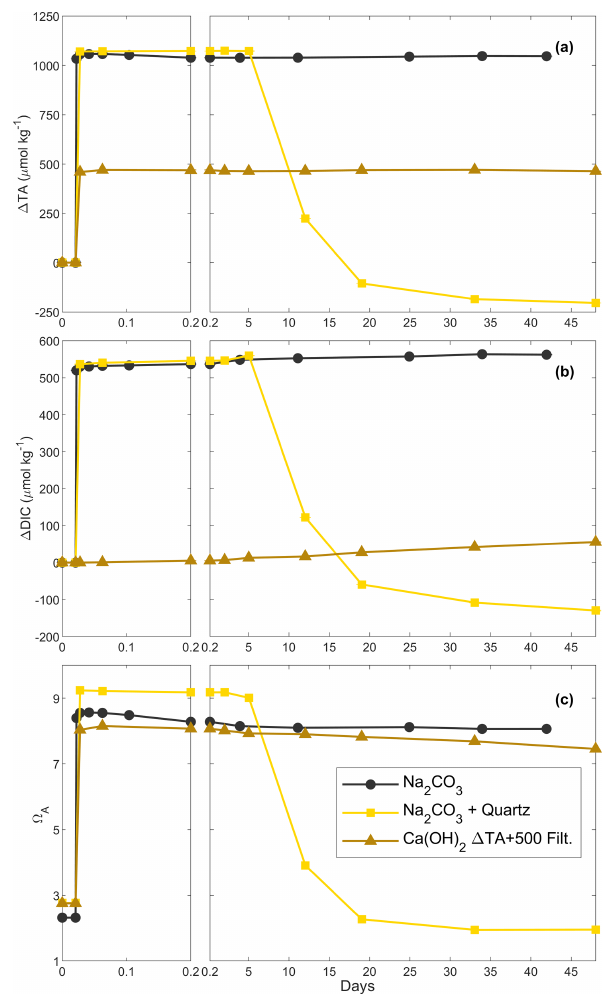
Figure 3. Changes in TA (a) , DIC (b) and (cid:127) A (c) over time fol- lowing additions of Na 2 CO 3 , Na 2 CO 3 plus quartz particles and Ca(OH) 2 followed by a filtration step (see “Material and methods” for